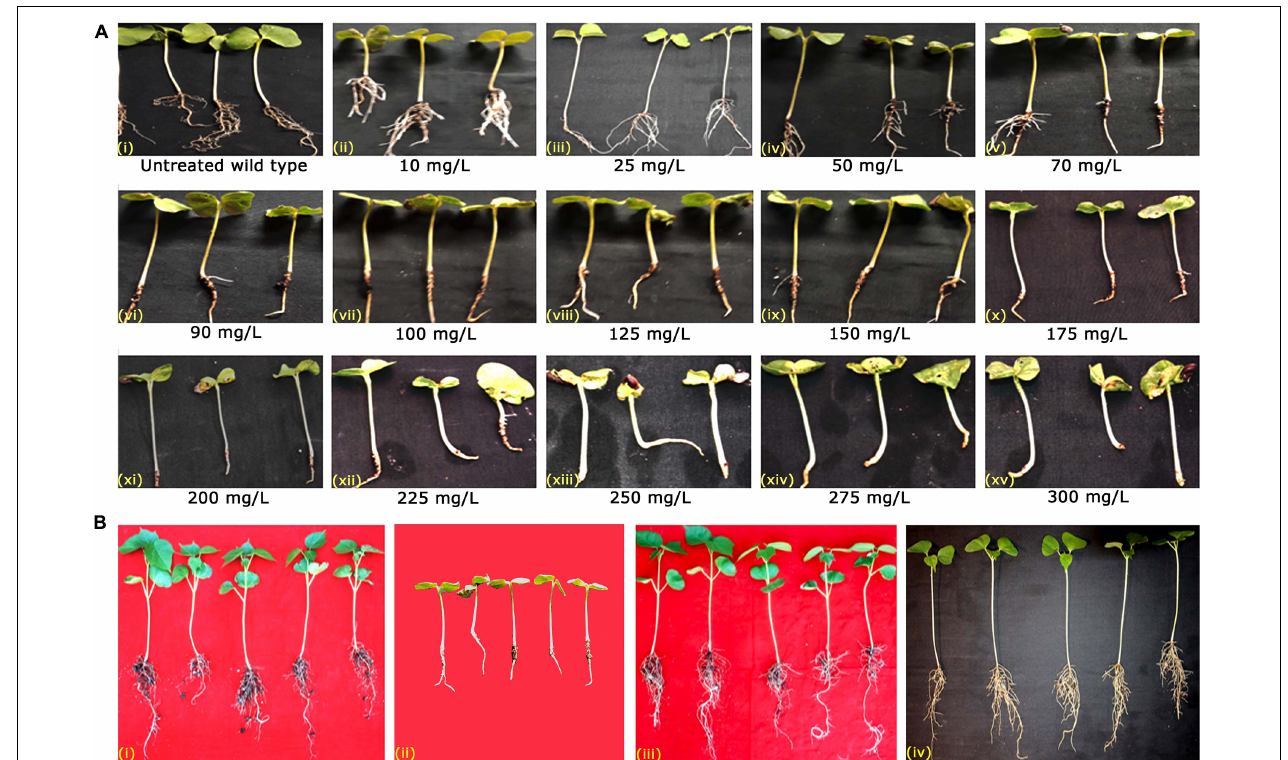
FIGURE 1 | Kanamycin screening for the identification of putative transformants. (A) Standardization of kanamycin concentration in cv. P8–6. Variation in the response of wild type seedlings to different kanamycin concentrations (i) untreated wild type, (ii) 10 mg/L, (iii) 25 mg/L, (iv) 50 mg/L, (v) 70 mg/L, (vi) 90 mg/L, (vii) 100 mg/L, (viii) 125 mg/L, (ix) 150 mg/L, (x) 175 mg/L, (xi) 200 mg/L, (xii) 225 mg/L (xiii) 250 mg/L, (xiv) 275 mg/L, and (xv) 300 mg/L. (B) Response of T 1 generation cotton seedlings to 150 mg/L of kanamycin (i) untreated wild type, (ii) treated wild type, and (iii,iv) Kanamycin-resistant T 1 generation transgenic plants.